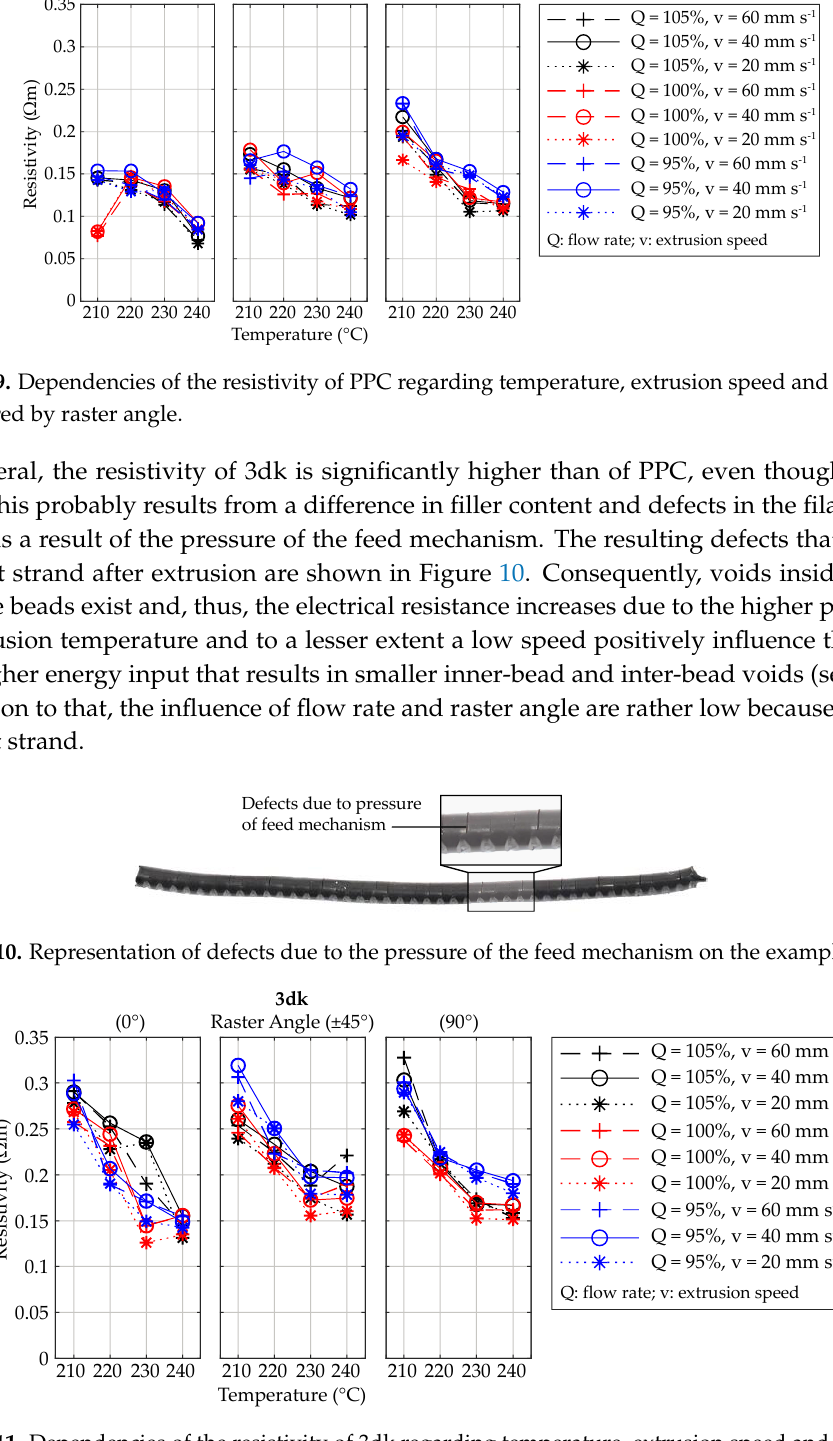
Figure 11. Dependencies of the resistivity of 3dk regarding temperature, extrusion speed and flow rate structured by raster angle.